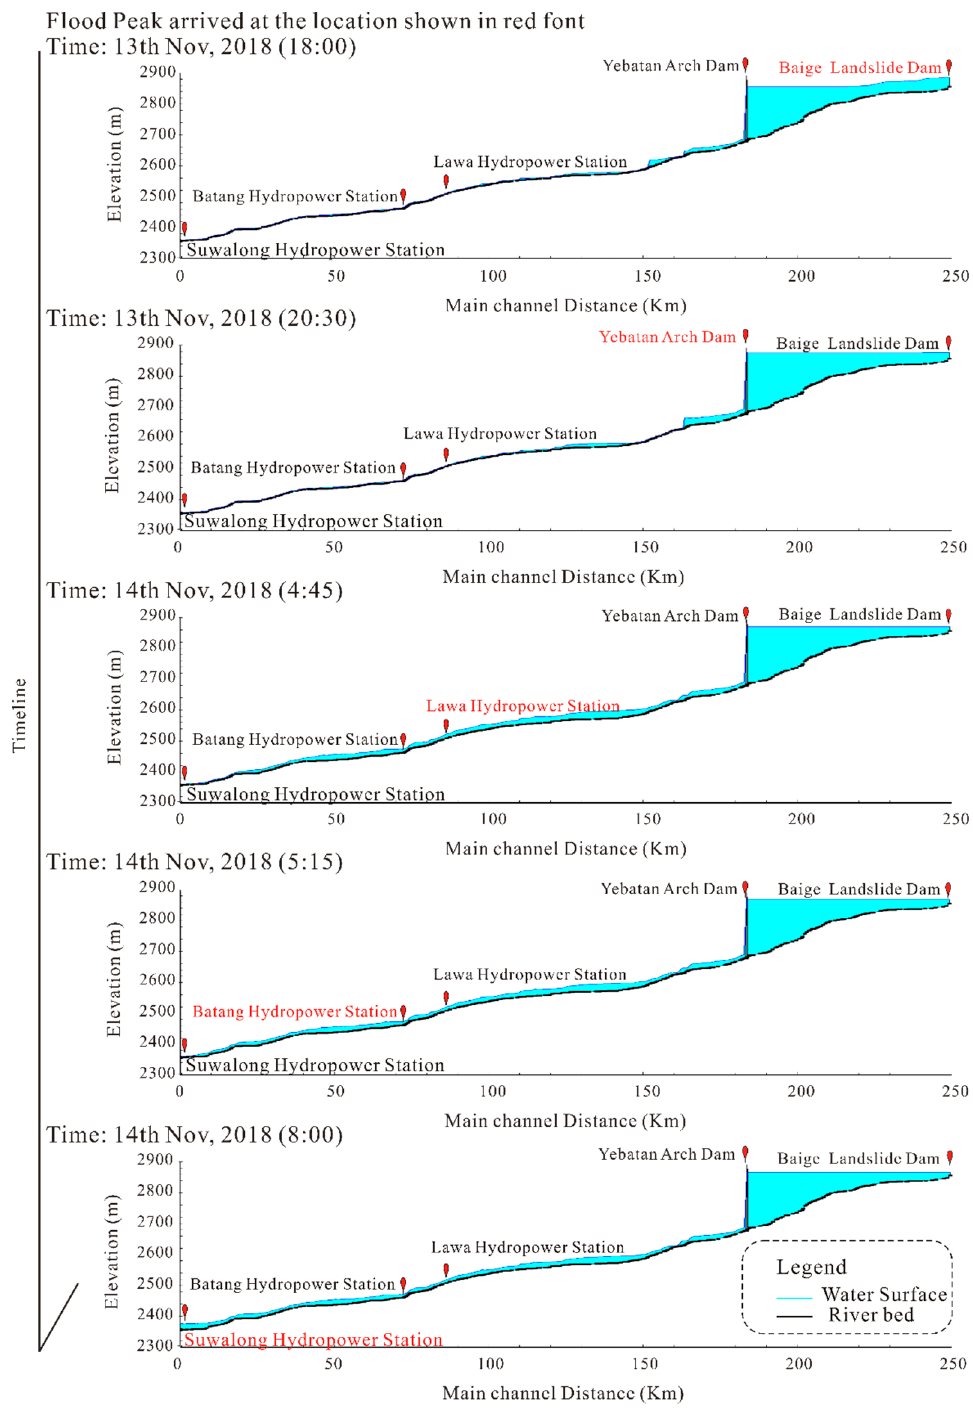
Figure 9. Water surface curves of the flood process with high dam interception (flood peak arrived at the location shown in red font).